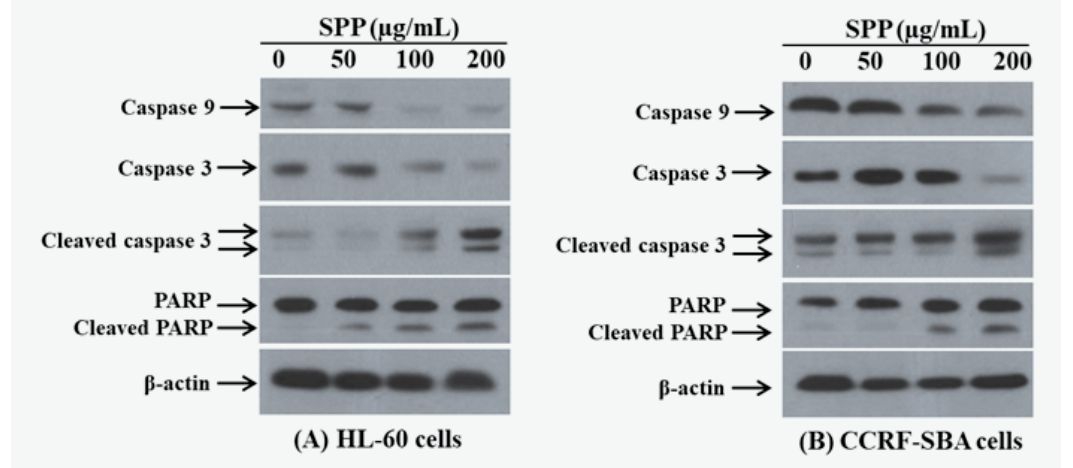
Figure 3. Influences of SPP on regulation of apoptotic signal proteins in HL-60 ( A ) and CCRF-SBA ( B ) cells. All experiments were repeated at least three times, obtaining similar results. Both cells were treated with SPP (0–500 µg/mL) for 48 h. β -Actin was used as a control, (–), 0.1% DMSO-treated cells. The experiments were carried out in three replicates.